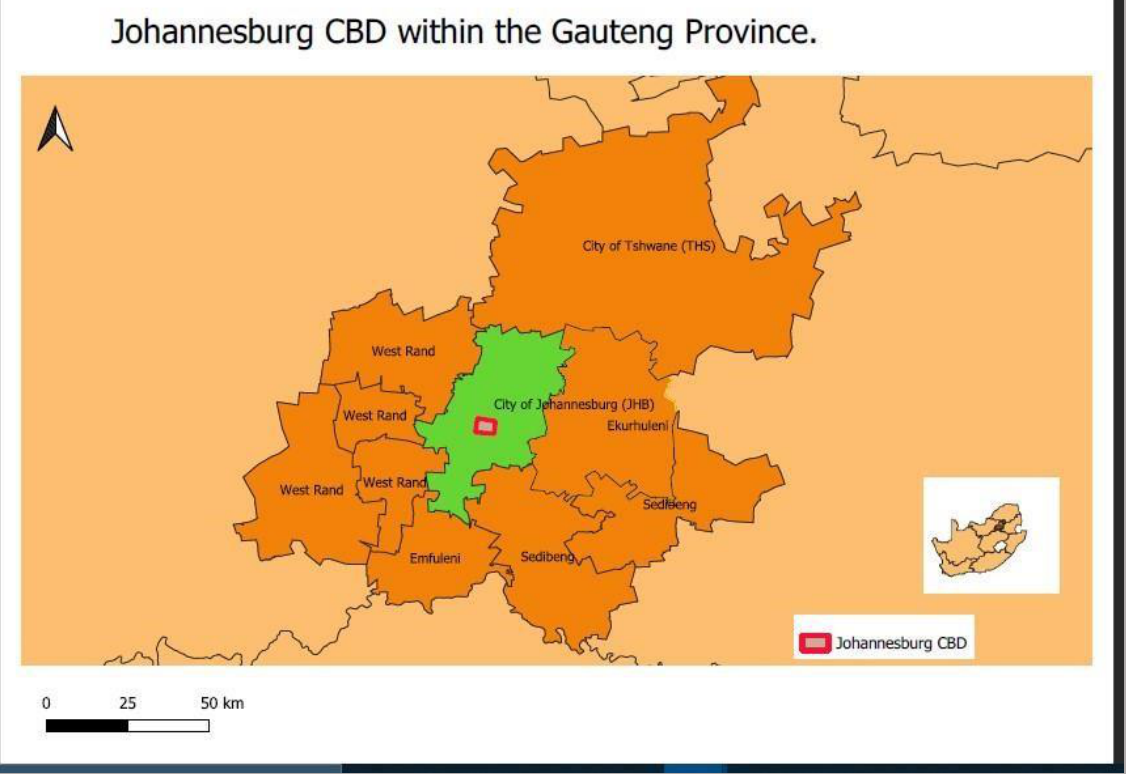
Figure 2 . Johannesburg